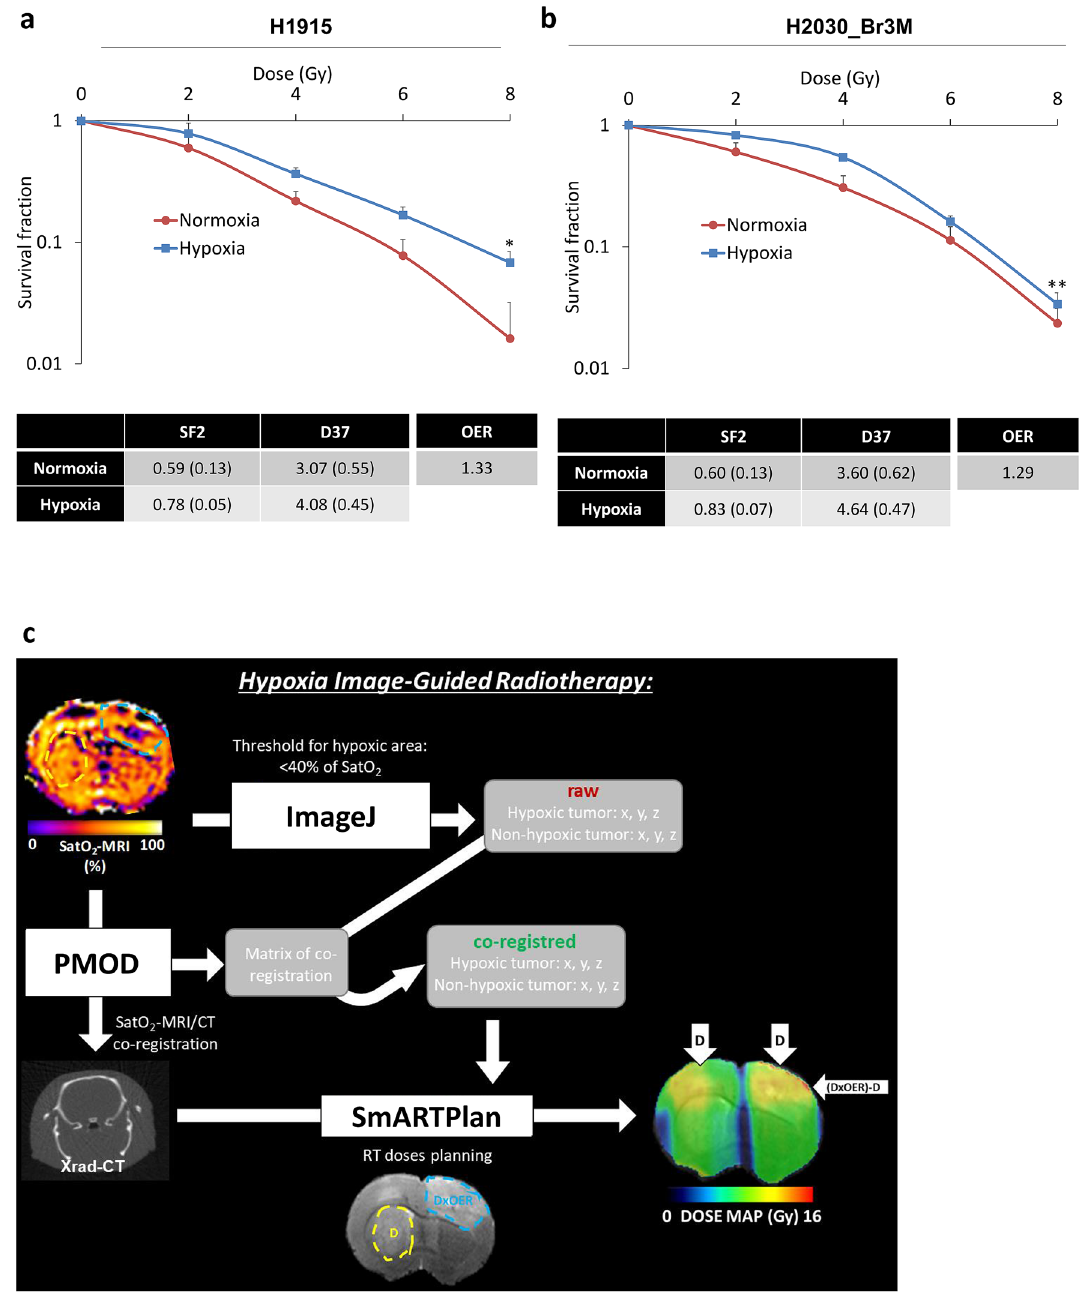
Figure 6. Radioresistance owed to hypoxia and HIGRT paradigm. ( a ) Quantitative analyzes of X-rays H1915 in vitro radiosensitivity in normoxia and hypoxia conditions (red and blue curves respectively). Mean ± SD, n = 4 for both conditions. * p < 0.05 for dose effect. SF2 = surviving fraction for 2 Gy; D50 = dose for which surviving fraction is 50%, OER (Oxygen Enhancement Ratio). ( b ) Quantitative analyzes of x-rays H2030-Br3M in vitro radiosensitivity in normoxia and hypoxia conditions (red and blue curves respectively). Mean ± SD, n = 4 for both conditions. * p < 0.05 for dose effect. SF2 = surviving fraction for 2 Gy; D50 = dose for which surviving fraction is 50%, OER (Oxygen Enhancement Ratio). ( c ) HIGRT paradigm showing the hypoxic and non- hypoxic BM revealed by SatO 2 -MRI leading to a boost of radiotherapy depending of the OER in the hypoxic